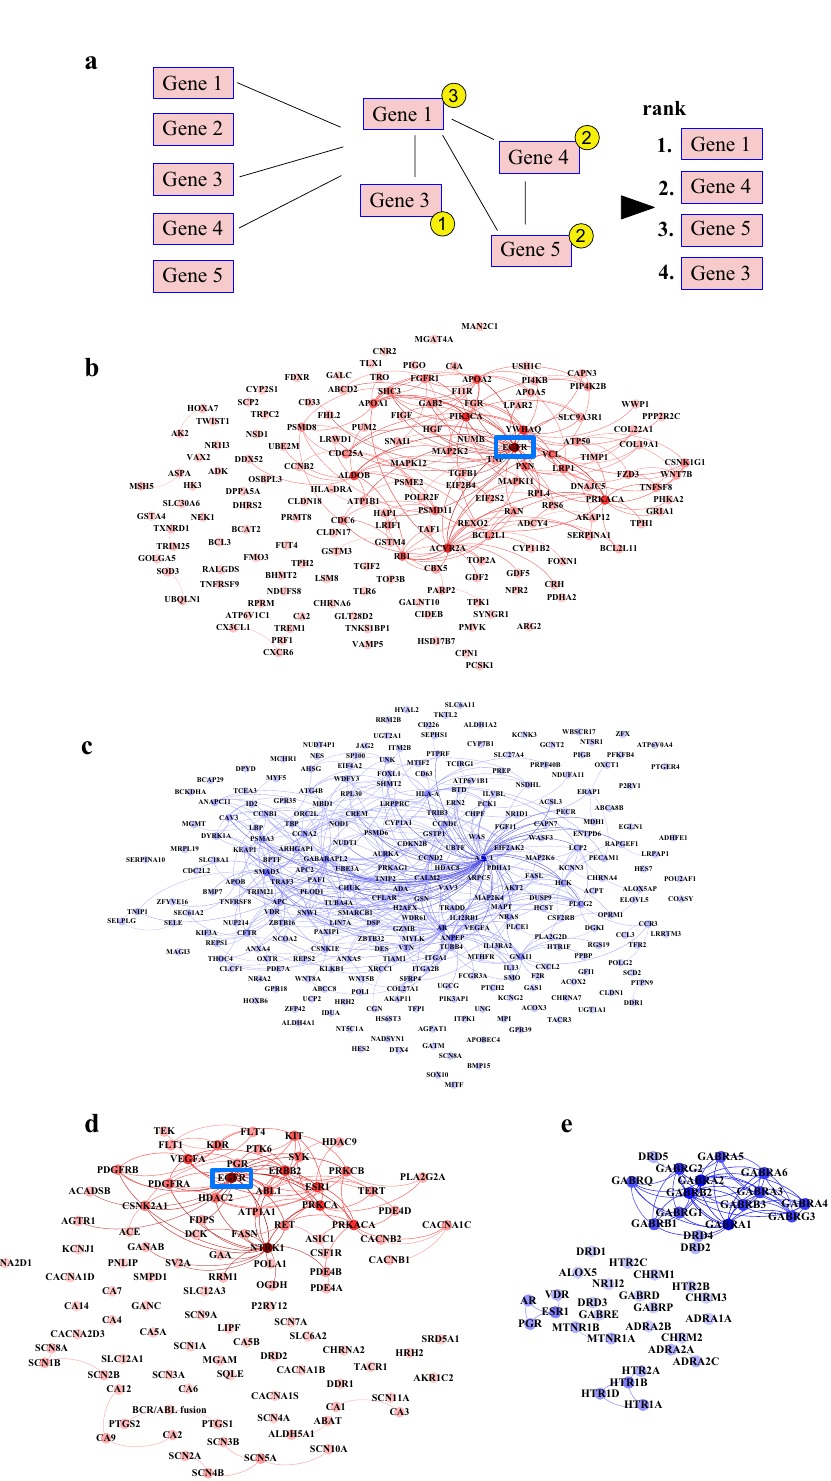
Figure 3. Protein–protein interaction analyses of significant hits from shRNA and drug library screens. ( a ) Schematic outline of the protein–protein interaction analysis. Significant gene or protein target hits from the screens were selected and number of their mutual interactions were calculated (depicted in yellow circles). Targets were subsequently ranked according to the number of their respective interactions. The lists were generated separately for down- and upregulated targets. ( b – e ) Significant hits from the screens were analyzed for their mutual interactions based on experimentally validated protein interaction information. Color of each node is scaled according to the quantity of interactions and color of each line corresponds to the node it originates from. ( b ) Genes down-regulated by shRNAs enriched by hypoxia-reoxygenation compared to normoxic controls. ( c ) Genes down-regulated by shRNAs depleted by hypoxia-reoxygenation compared to normoxic controls. ( d ) Protein targets of antagonistic drugs enhancing survival in hypoxia-reoxygenation. ( e ) Protein targets of agonistic drugs enhancing survival in hypoxia-reoxygenation. EGFR is highlighted with a blue